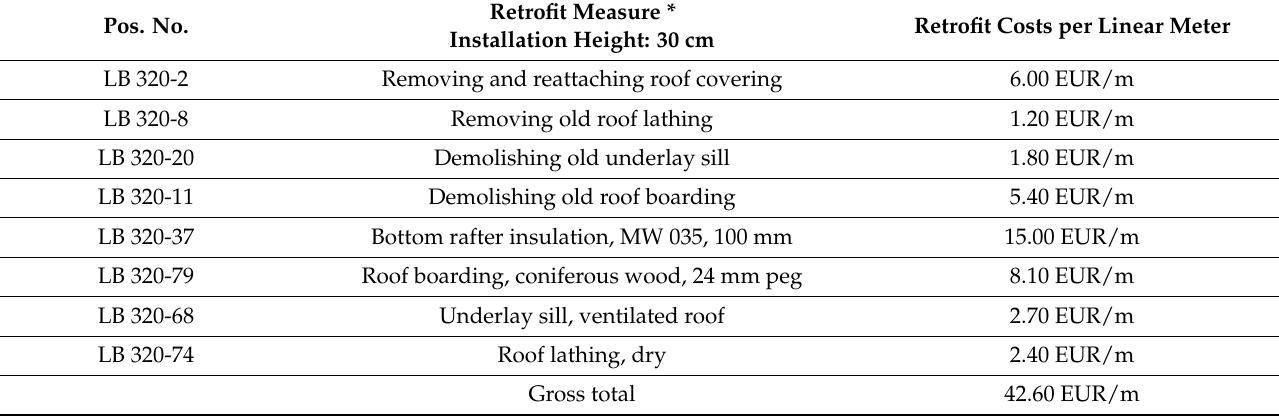
Table A30. Retrofit components and costs of the thermal bridge retrofit of a connection between a rooftop and a wall [38,39]. Pos. No.